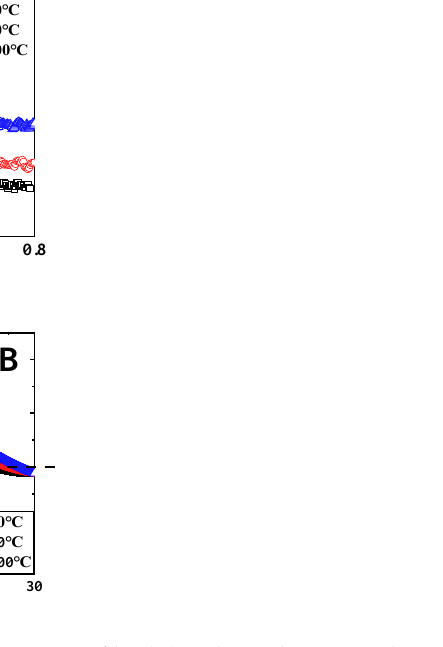
Figure 7. The Lorentz-corrected SAXS profiles ( A ) and one-dimensional correlation function ( B ) of the PLLA/TAIC (60/40) blend after cold crystallization at the indicated temperatures. Table 2. Long period, thickness of lamellae, amorphous layer, crystallinity from SAXS and DSC upon cold crystallization at the indicated temperatures.